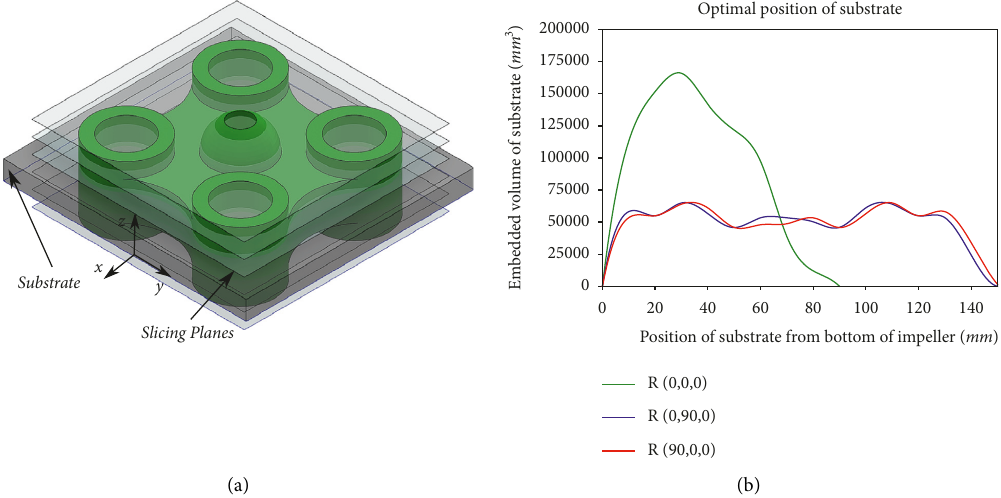
Figure 12: Illustrative example 6: (a) CAD model and (b) VI for different positions of the substrate with different orientations.